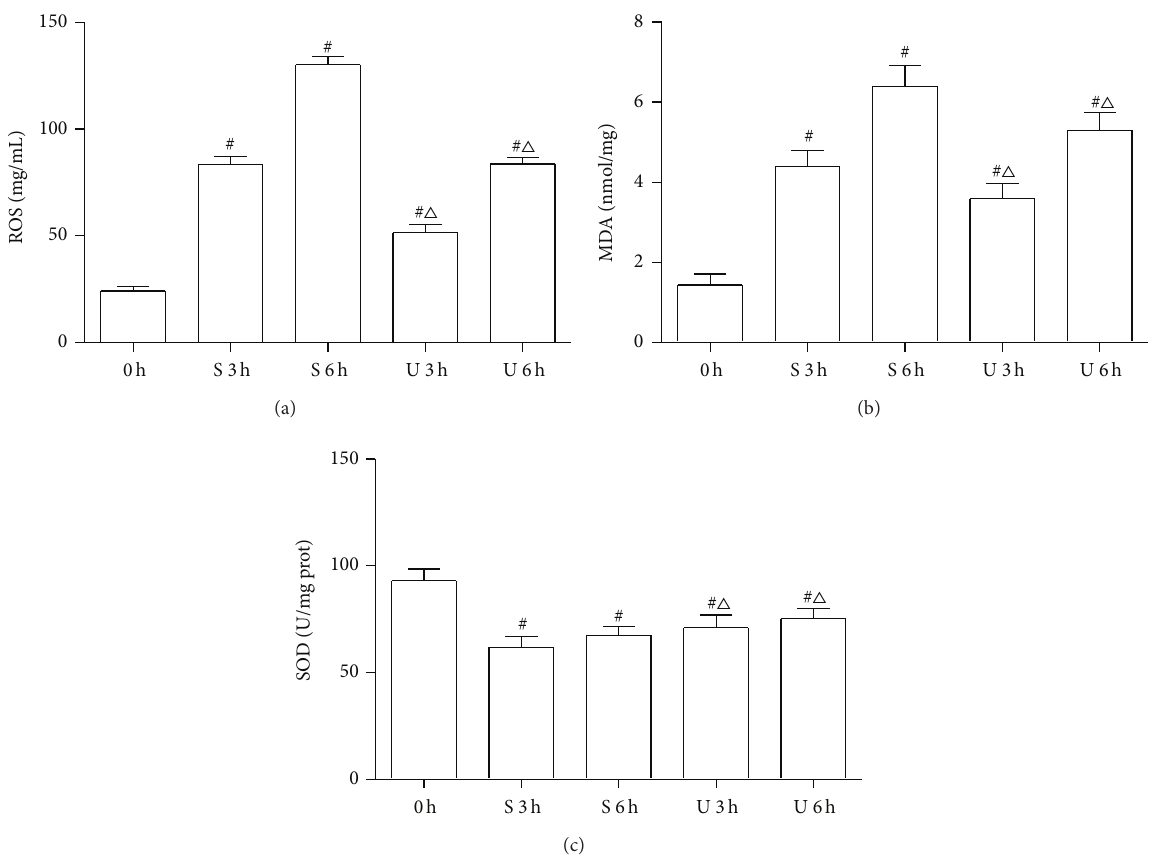
Figure 2: Effects of UTI on ROS (a), MDA (b), and SOD (c) of intestinal tissue. 0 h = C group; S 3h = S group at 3 h; S 6h = S group at 6 h; U 3 h = U group at 3 h; U 6h = U group at 6h. # 𝑃 < 0.05 versus C group and △ 𝑃 < 0.05 versus S group at matched